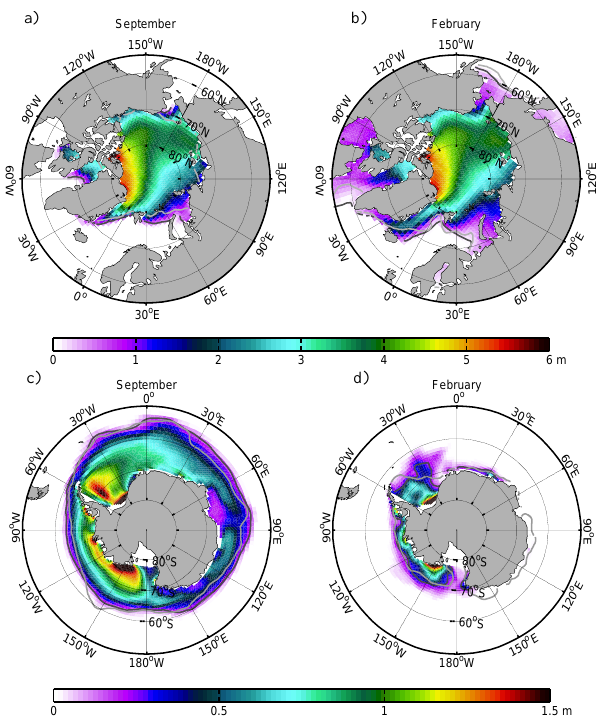
Fig. 1. Simulated mean sea-ice thickness (1979–2005) in September (a, c) and in February (b, d) in the NH (a, b) and SH (c, d) . The dark and light grey lines correspond to the simulated and observed sea-ice edges (15% limit), respectively. Observations come from OSISAF (Eastwood et al.,